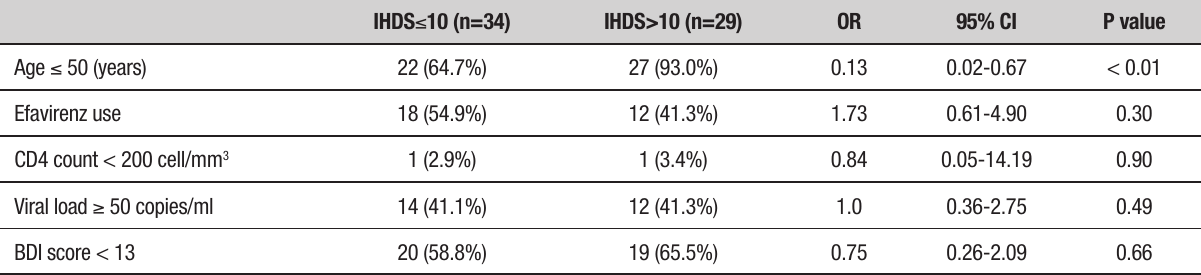
Table 3. Univariate analysis of factors associated with performance on the International HIV Dementia Scale